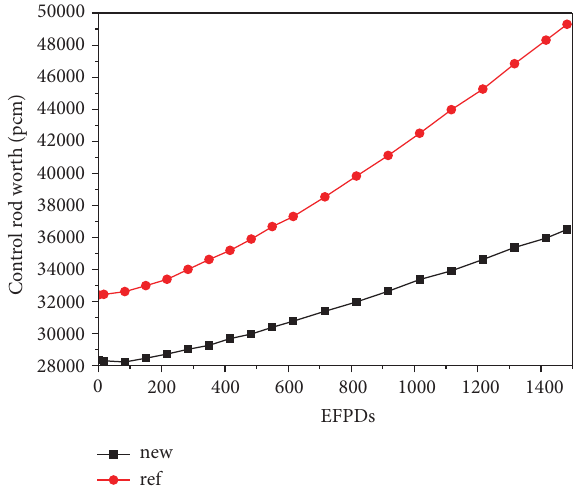
Figure 13: Control rod worth versus